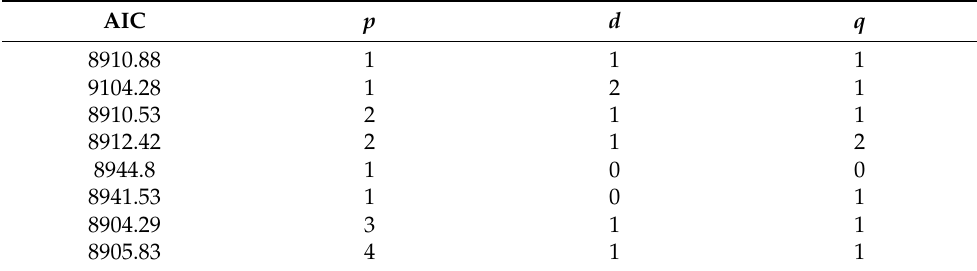
Table 2. Autoregressive integrated moving average (ARIMA) model specification and corresponding of the autoregressive, d represents the difference and q represents the